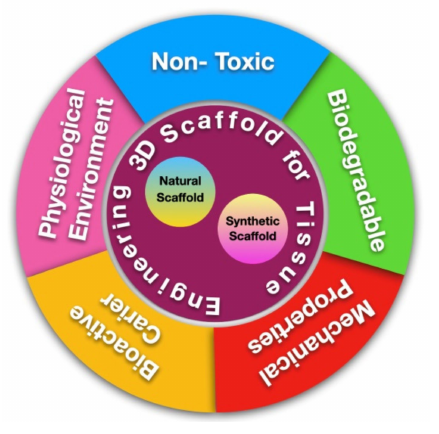
Figure 1. Scaffold for Tissue